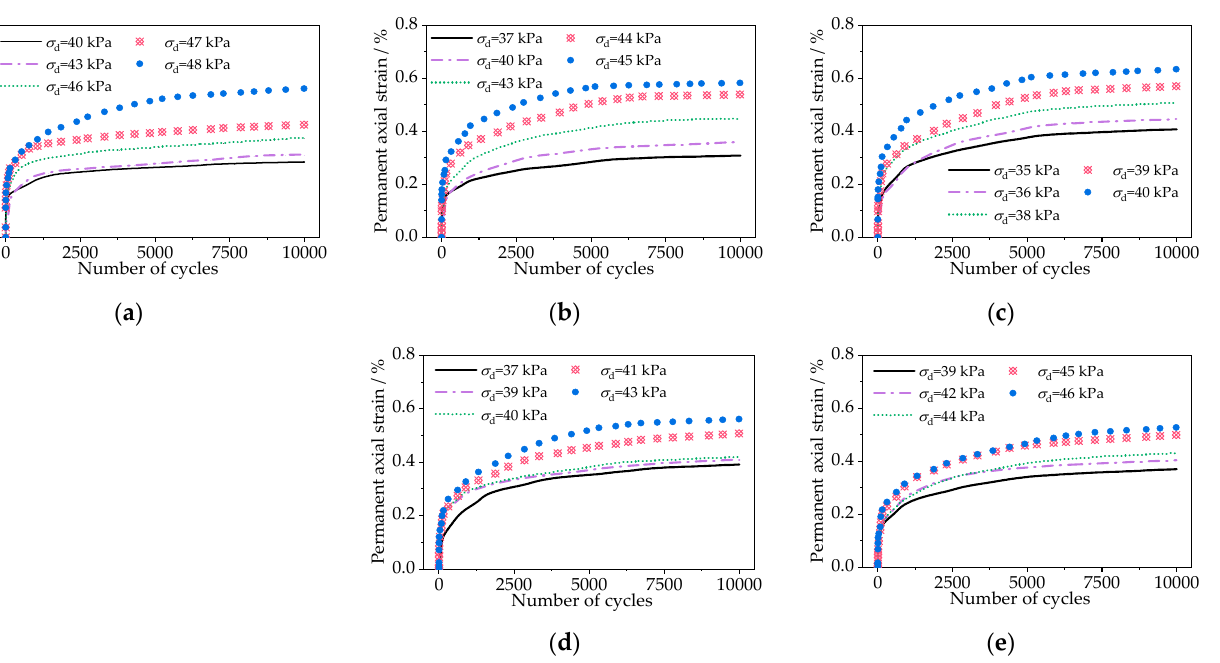
Figure 7. Permanent axial strain of the saturated silt with different fine particle contents under drained conditions. ( a ) 7% fine particle content; ( b ) 8% fine particle content; ( c ) 10% fine particle content; ( d ) 12% fine particle content; ( e ) 14% fine particle content.